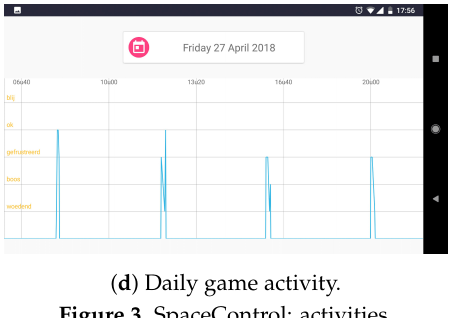
Figure 3. SpaceControl: